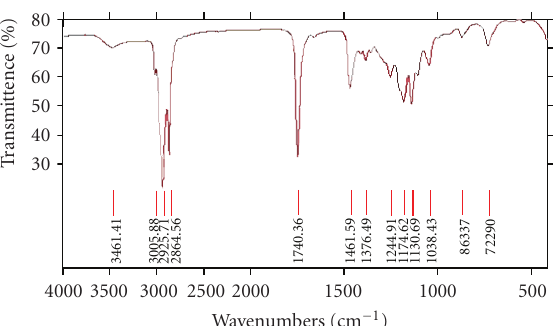
Figure 3: IR spectrum of rapeseed oil monoester .